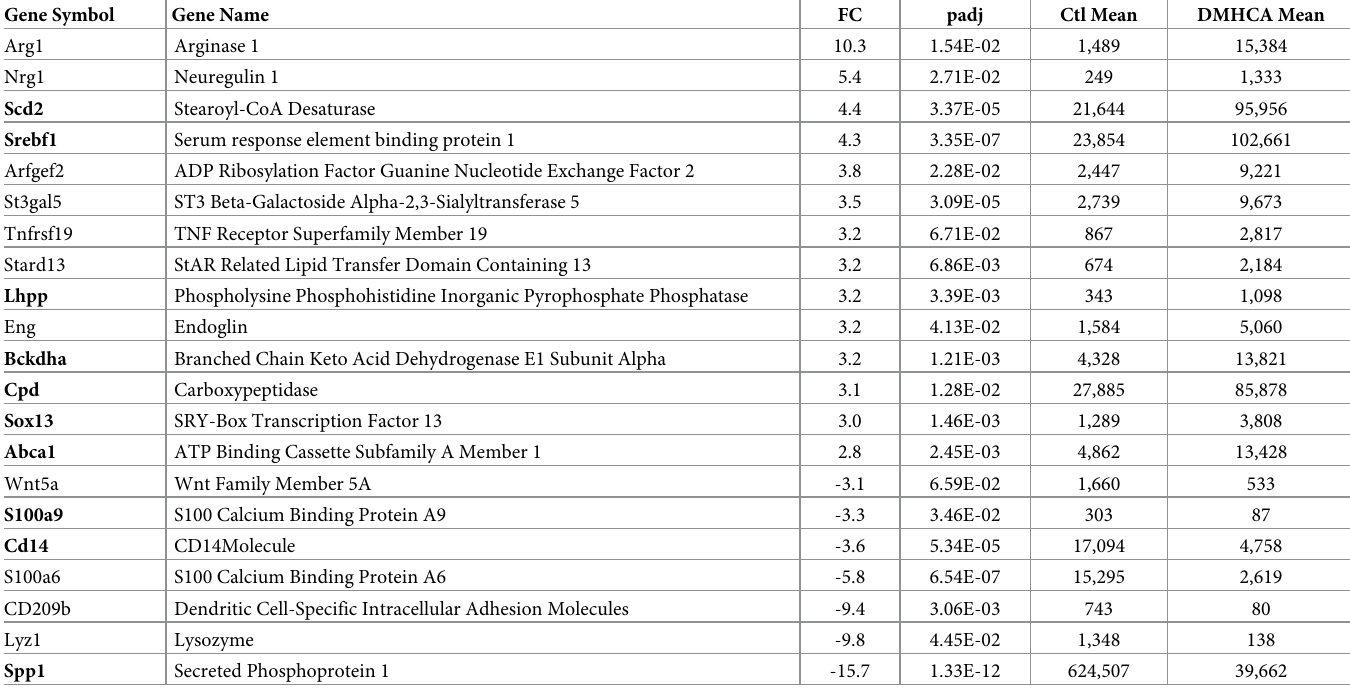
Dendritic Cell-Specific Intracellular Adhesion